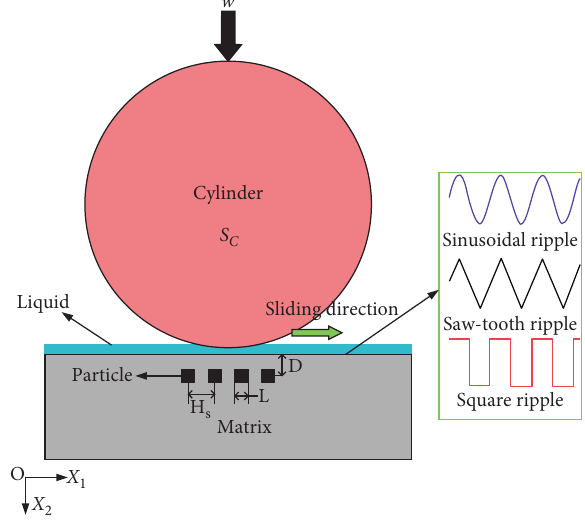
Figure 1: EHL in line contact with different rough surfaces.